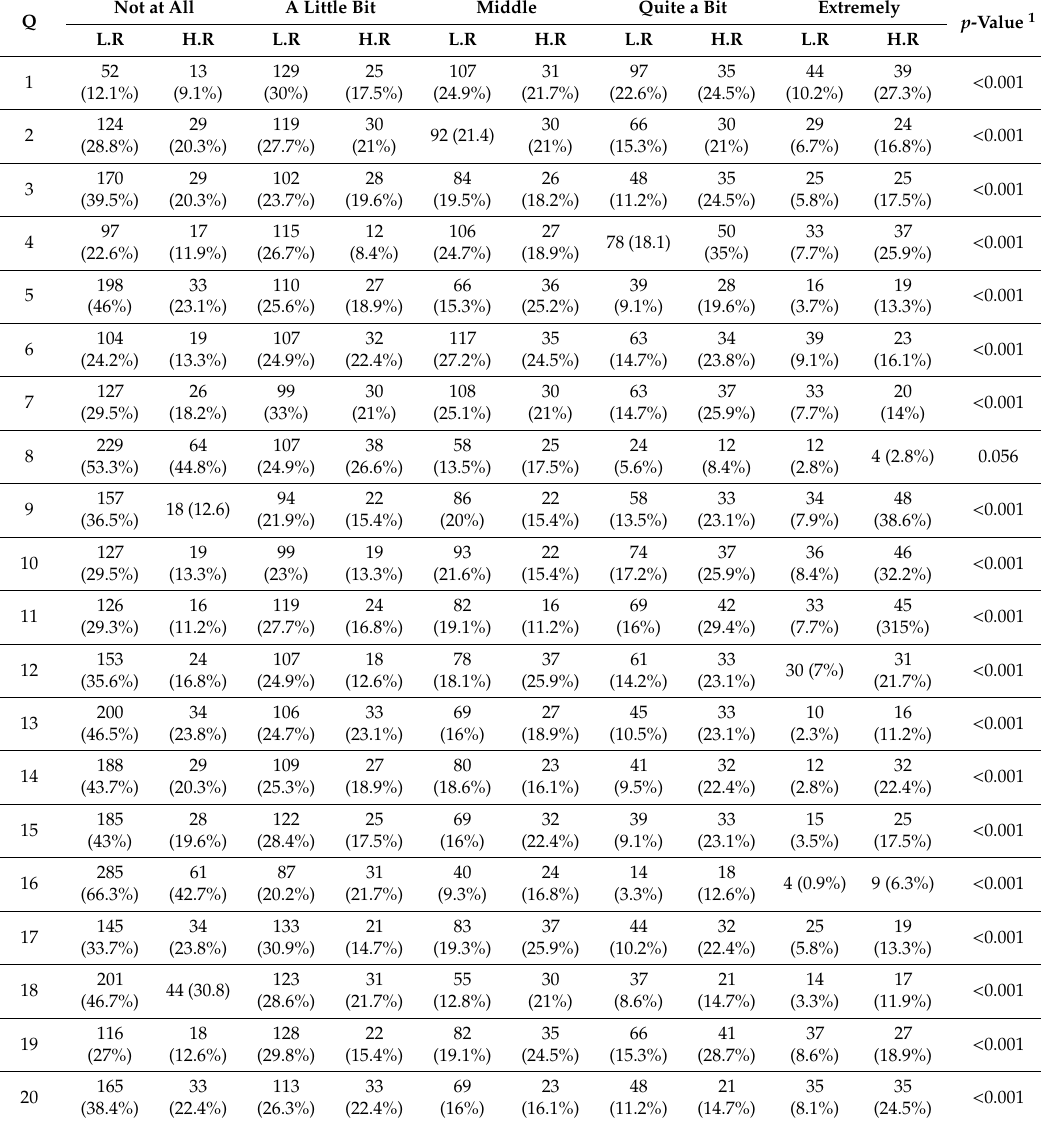
Table A2. Frequency of the post-traumatic stress disorder (PTSD) Symptomatology (PCL-5) in low (L.R) and high-risk (H.R) groups (Cut-o ff = 31). Not at All A Little Bit Middle Quite a Bit Extremely Q